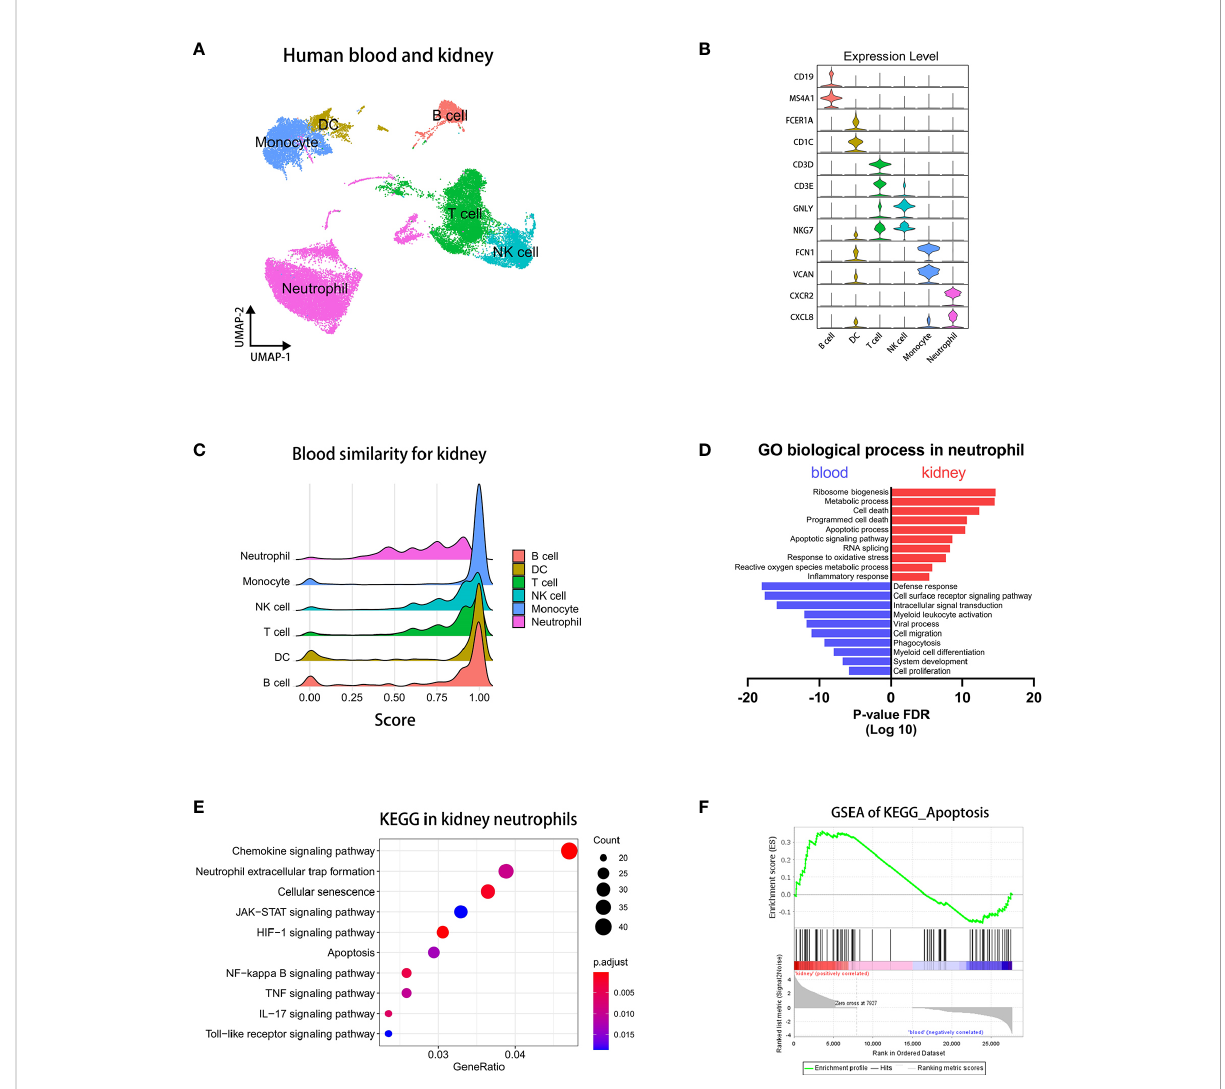
FIGURE 2 Integrated analysis of sc-RNAseq data reveals pro-apoptotic status in kidney neutrophils. (A) UMAP plot clustering of immunocytes in blood and kidney. (B) Violin plots displaying the marker genes of identi fi ed subsets. (C) The bridge plots showing similarity scores in blood subsets comparing to corresponding subsets in the kidney. (D) The enrichment analysis of GO biological process in blood and kidney neutrophils. (E) The KEGG analysis of signaling pathways in differentially expressed genes of kidney neutrophils. (F) The GSEA plots of the apoptosis